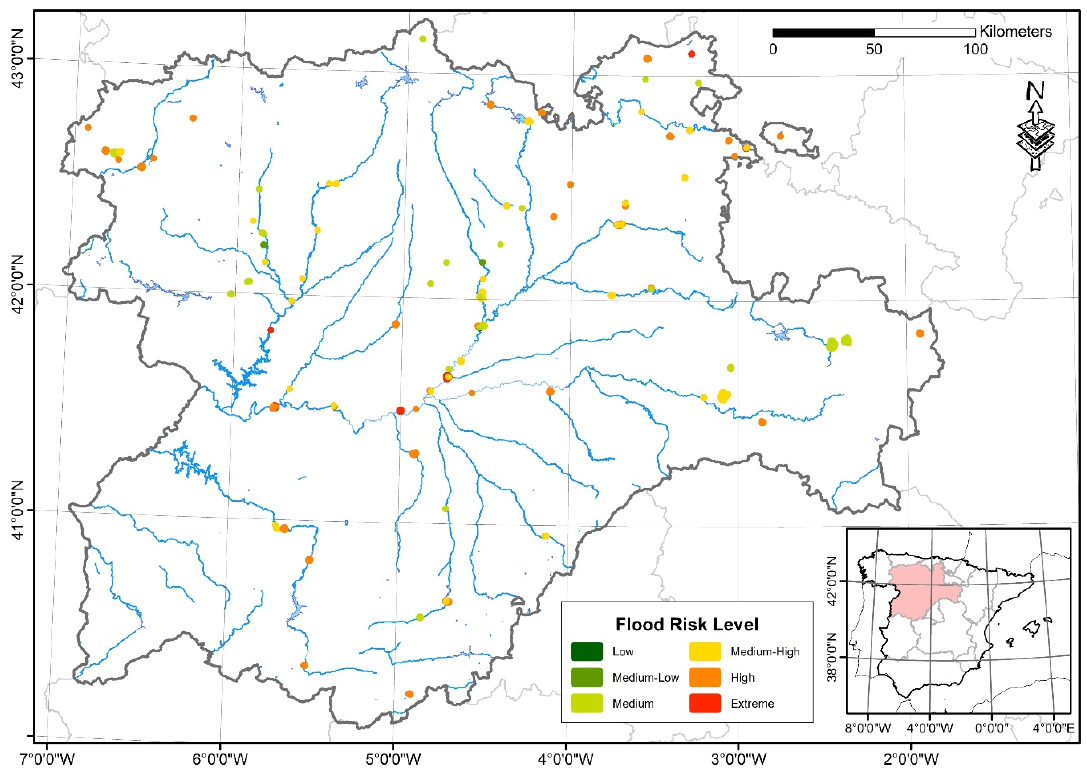
Figure 8. Spatial distribution of BICs in Castile and León region and their associated flood potential risk level.